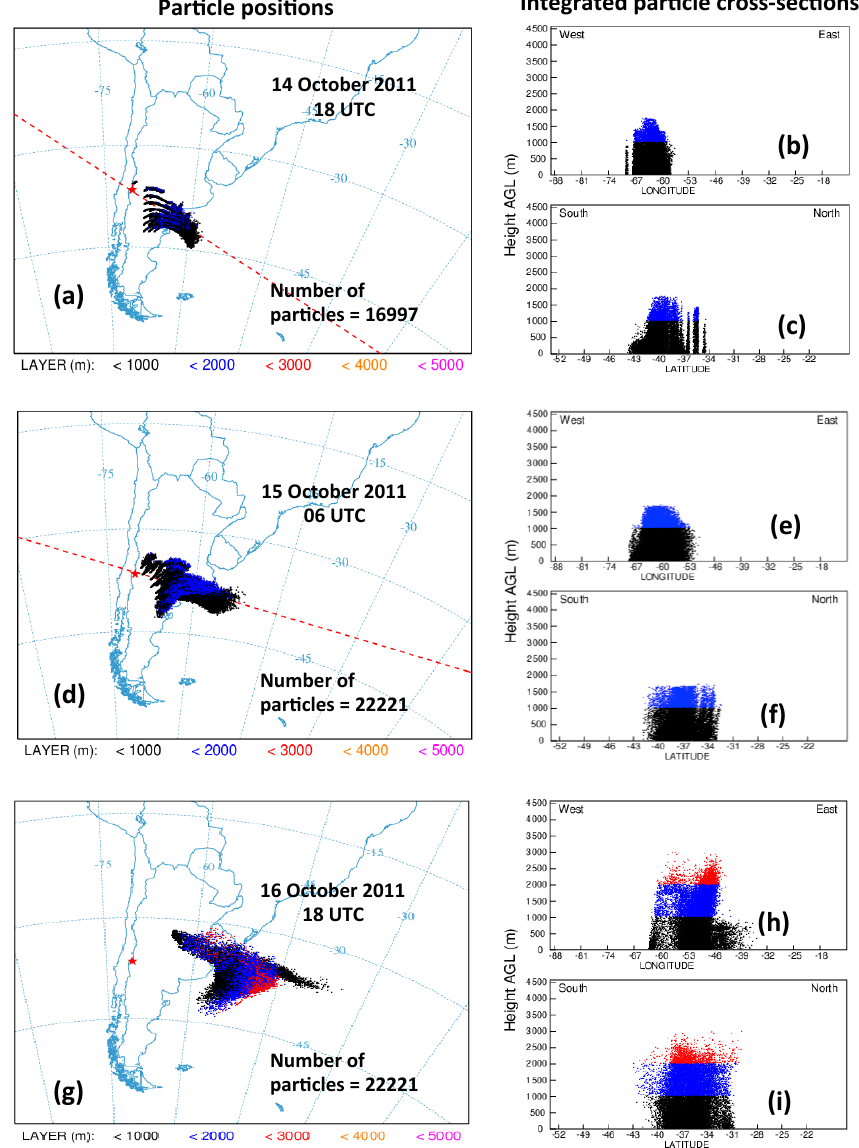
Figure 7. HYSPLIT simulations from 14 to 16 October 2011: (a, d, g) particle positions at surface; (b, e, h) W–E integrated particle cross sections; (c, f, i) S–N integrated particle cross sections. The red dashed line denotes the regression line through the particle positions.